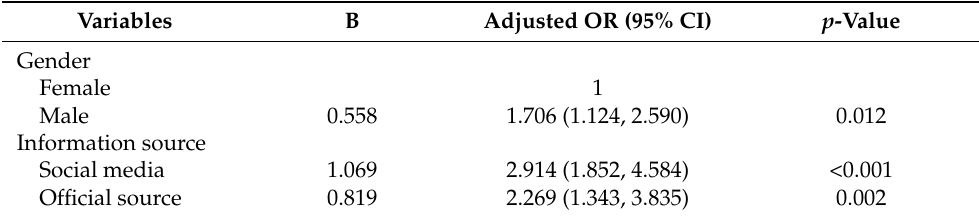
Table 4. Multiple Logistic Regression based factors on the readiness level of night market street food hawkers about supporting the single-use plastic reduction program in Kelantan ( n =